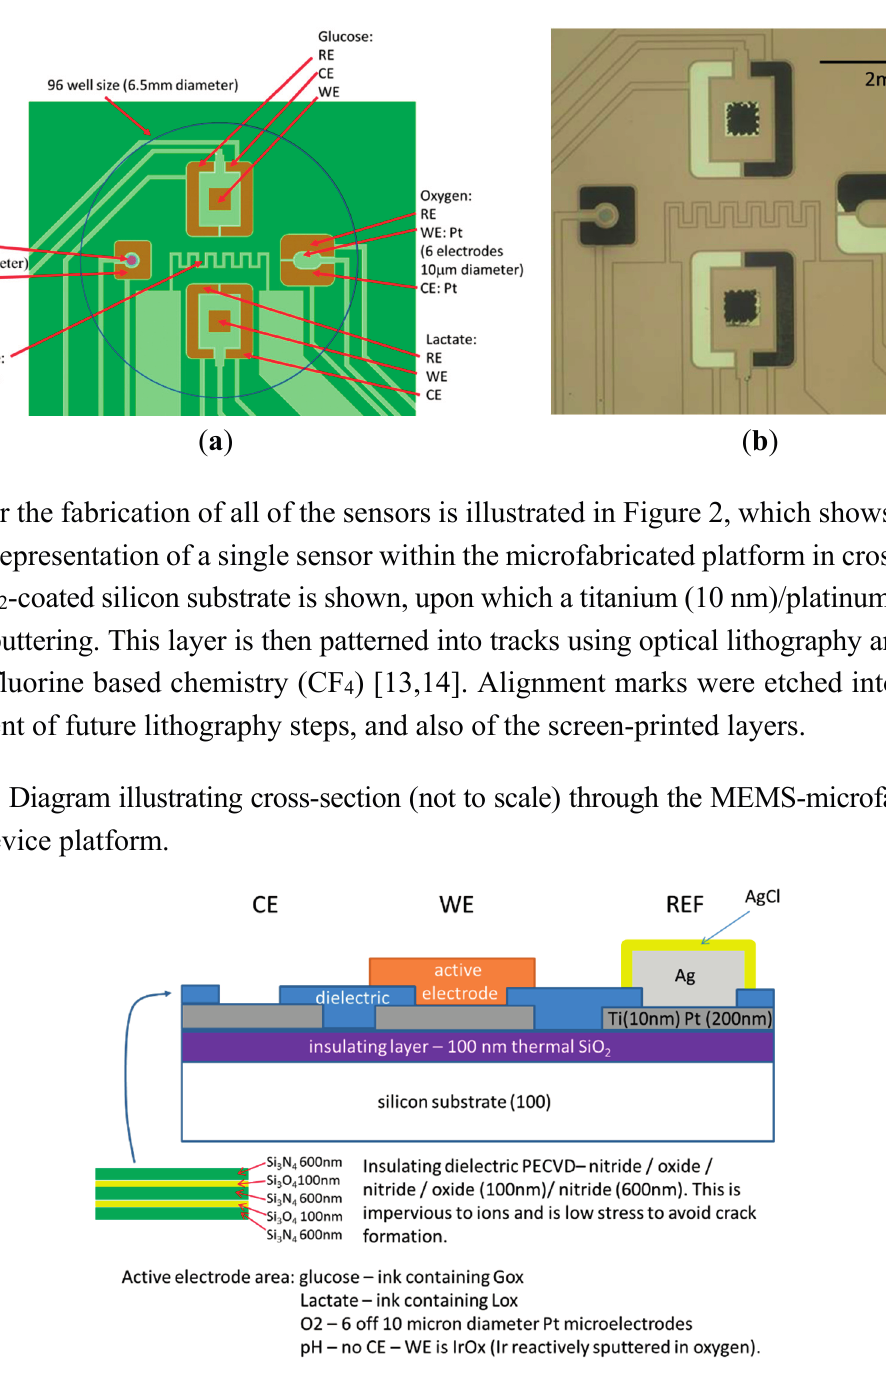
Figure 1. ( a ) Scale diagram of integrated well design for microstructured sensor/biosensor chip base showing locations of four sensors and Pt resistance thermometer in a single 96-well format; ( b ) Photograph of part of the completed 5-well strip showing the sensors printed within the region of a single 96-well.